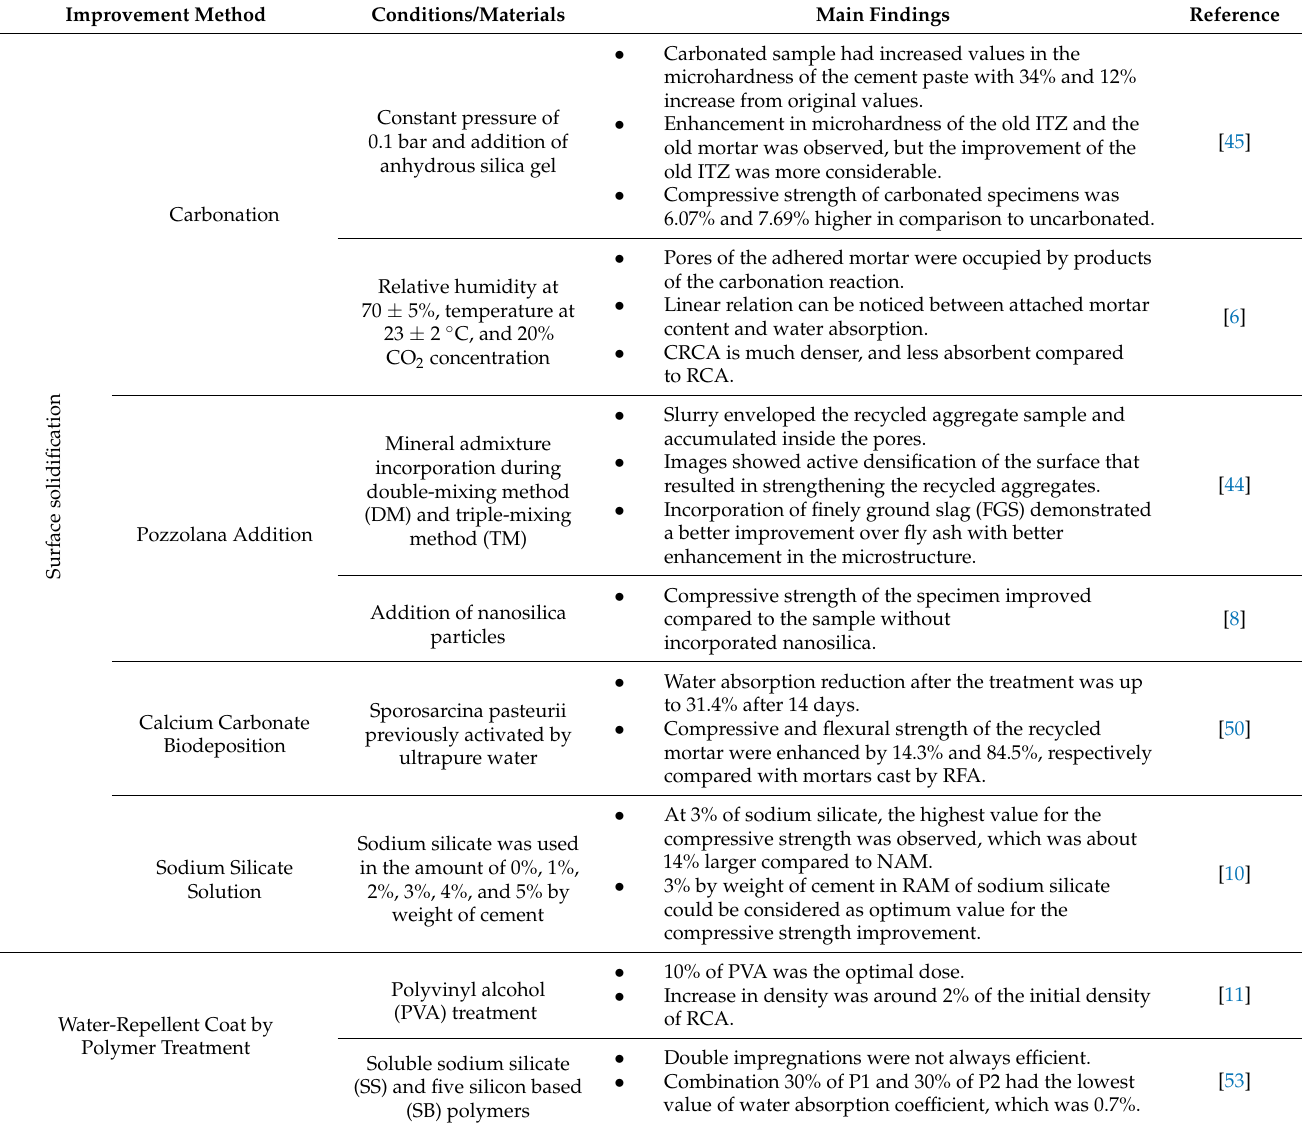
Table 6. Improvement methods for adherent mortar of